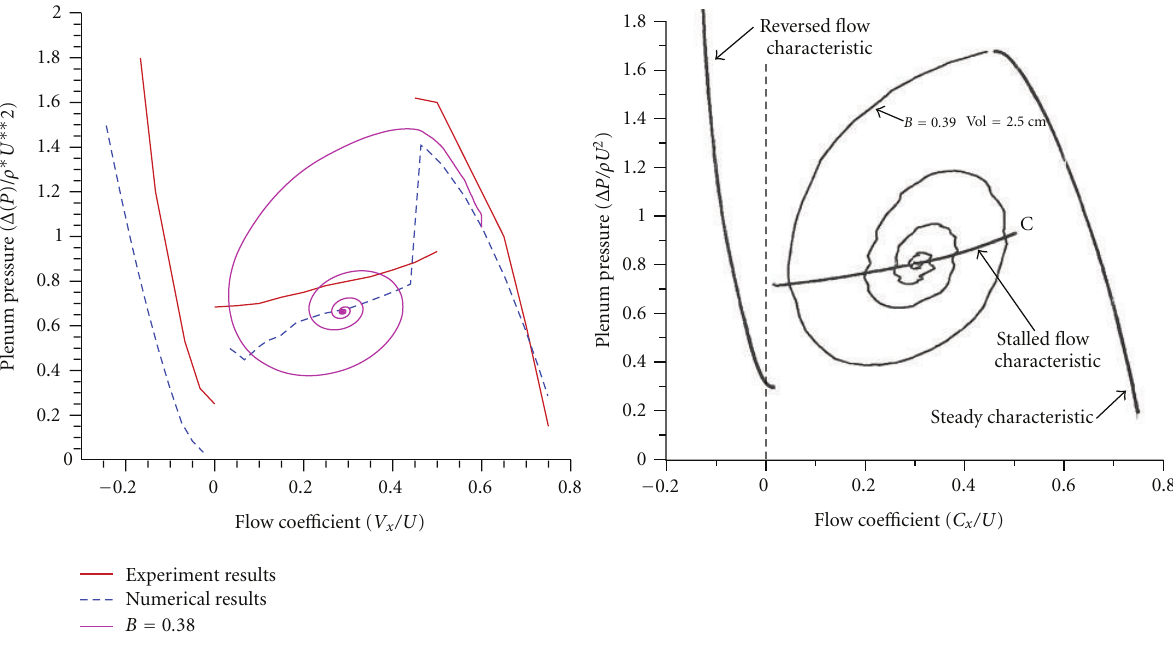
Figure 5: Numerical and experimental trajectory of compressor operating point during rotating stall